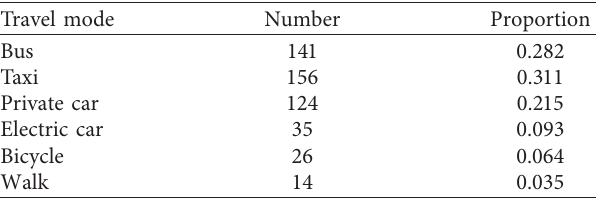
Figure 4: Supply-demand relationship diagram based on tourist travel behaviour. Table 1: Travel methods for